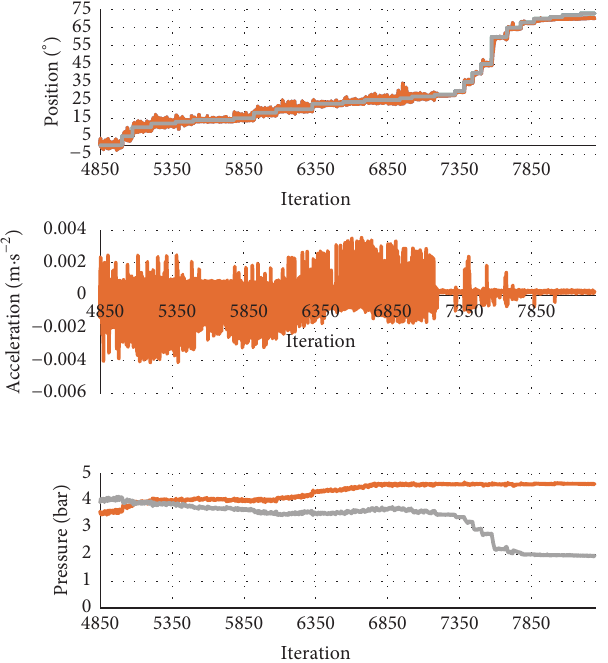
Figure 13: Graphical representation of the experimental measure- ment number 2; positioning accuracy = 1.5 ∘ .